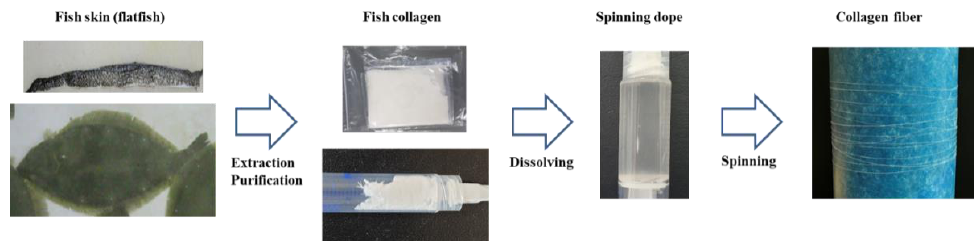
Figure 1. Schematic representation of fish skin-based collagen extraction and fiber spinning.